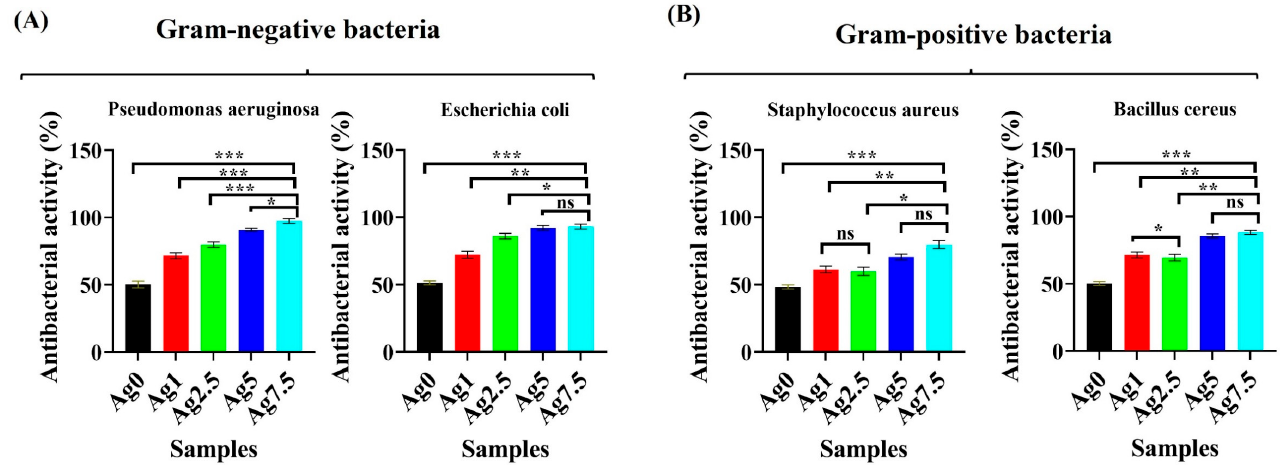
Figure 12. The result of antibacterial activity of the un-doped and Ag-doped 1393B3 MBGs against gram-negative ( A ) and gram-positive ( B ) bacteria species. (* p ≤ 0.05, ** p ≤ 0.01, *** p ≤ 0.001, ns means not